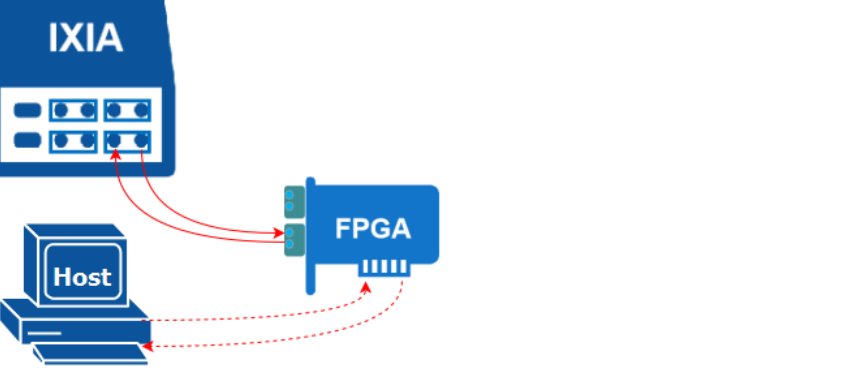
Figure 7. Equipment connection diagram.